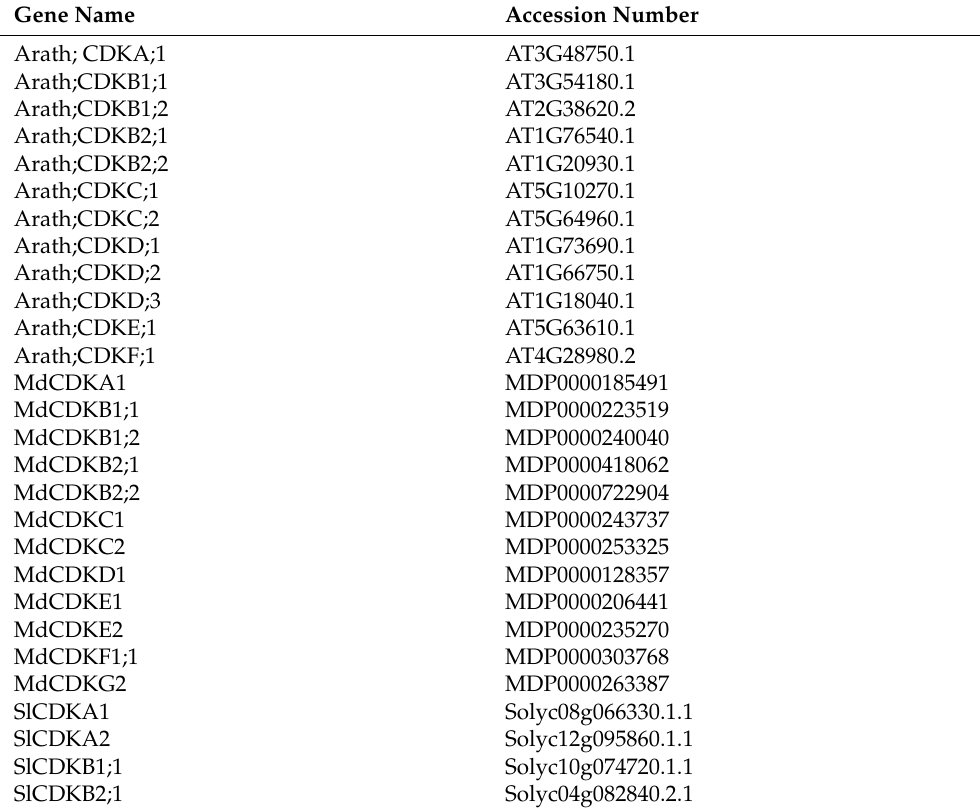
Table 2. Gene name and accession number of CDKs from three different plant